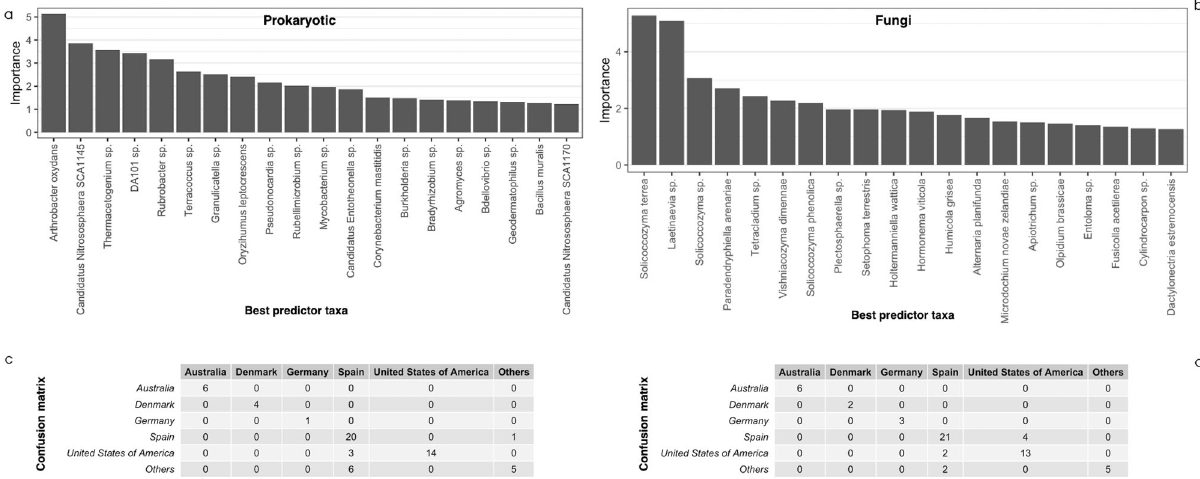
Fig. 4 Random forest results at national scale including only microbial data. The top charts show the 20 best predictors for prokaryotic ( a ) and fungal ( b ) communities; the bottom charts show the confusion matrixes for the prokaryotic ( c ) and fungal communities ( d